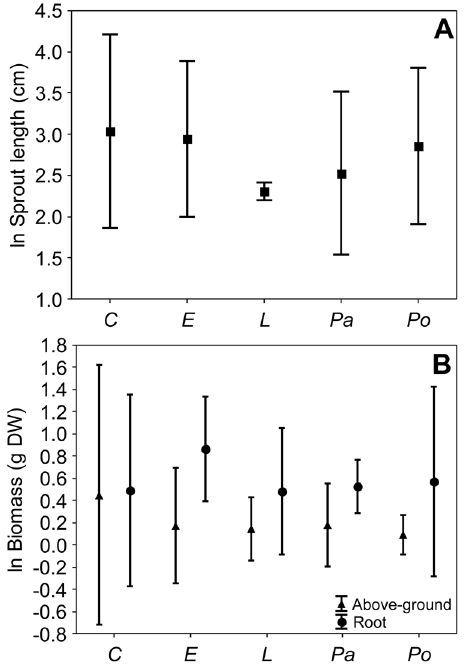
Figure 1. Effects of single native species on Urochloaarrecta growth. Sprout length (A) and aboveground and root biomass (B) of U. arrecta (mean 6 95% CI) when cultivated in monocultures in our first experiment. C = Commelina diffusa , E = Eleocharis montana , L = Leersia hexandra , Pa = Panicum pernambucense , Po = Pontederia cordata .